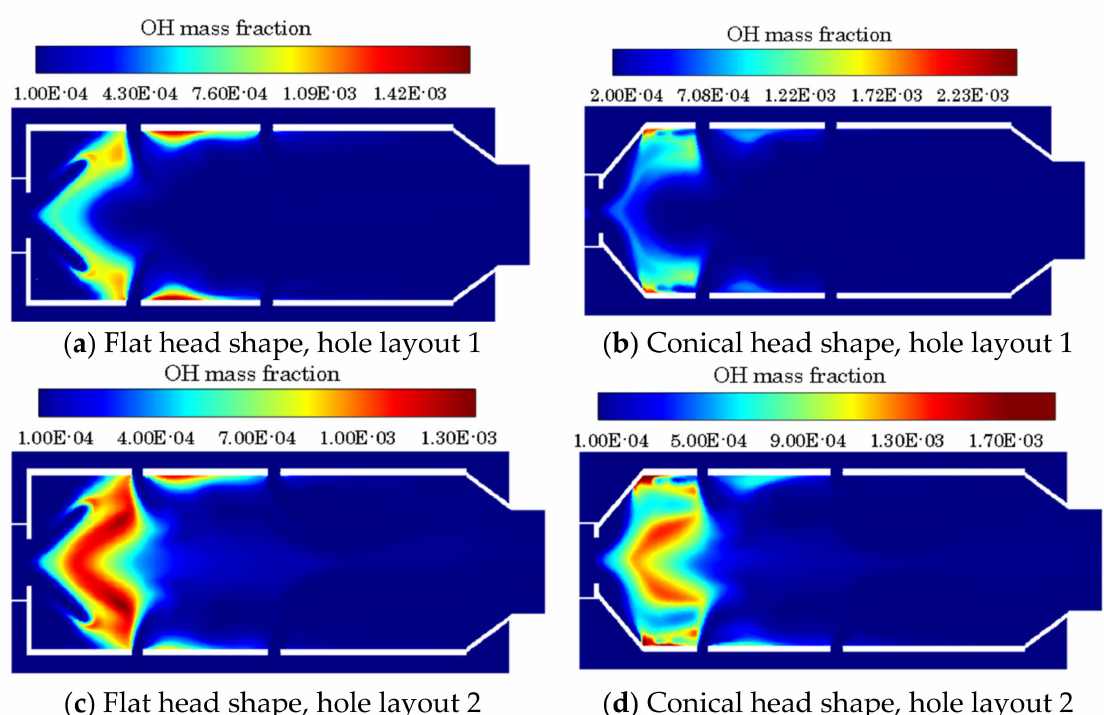
Figure 6. Reacting flow velocity contours with streamlines for various dome cases.